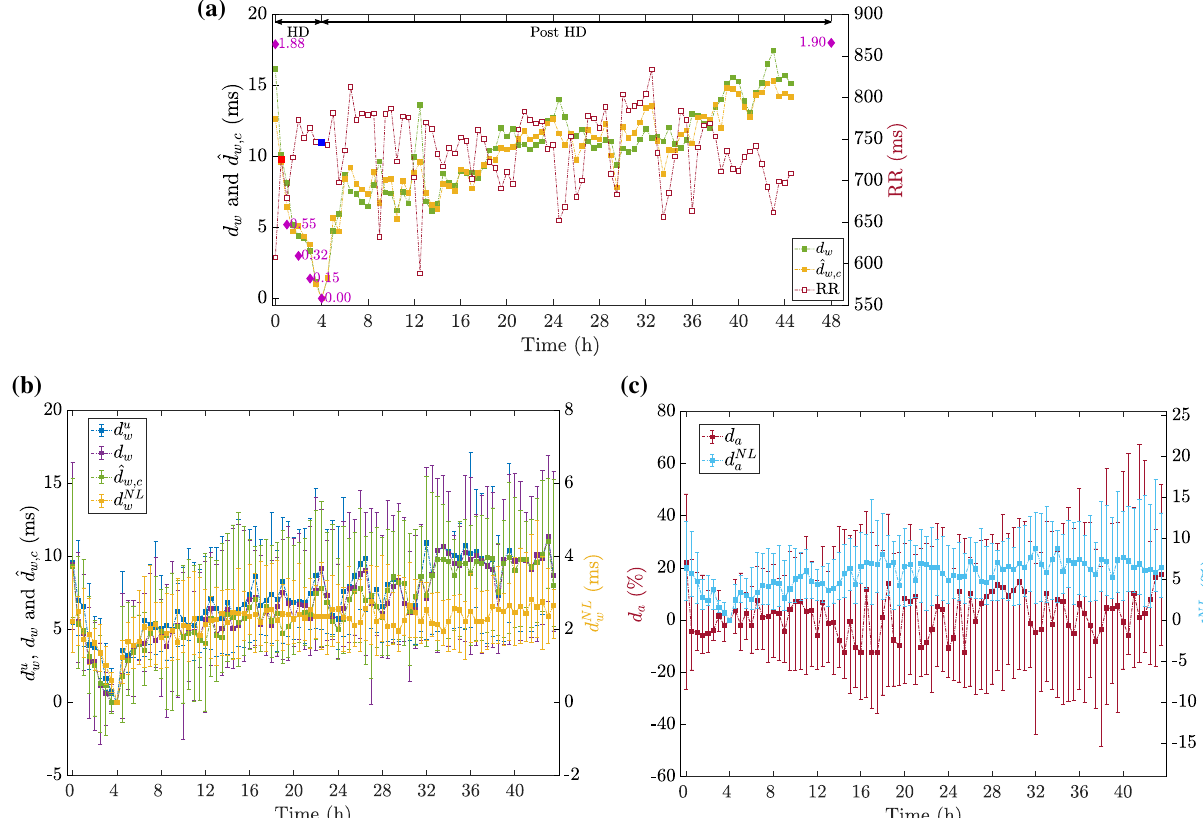
Figure 5. PCA-based time-warping markers and RR interval time trends. An example for a given patient undergoing 4h-long HD therapy, is depicted in panel ( a ) with the evolution of d w (filled green squares), (filled orange squares), both referring to the left vertical scale, and the average RR intervals (unfilled dark red squares, referring to the right vertical scale). (cid:31) [ K + ] relative variations with respect to the concentration at HD end (purple diamonds) are expressed in mmol/L. Time is expressed in hours from the beginning of the treatment onward. Each square denotes the mean RR interval in a 2-min wide segment used to compute the warping parameters, while the highlighted blue square corresponds to the reference segment at the end of HD. The filled red square denotes the time-point from which the studied MWTW in Fig. 2b was selected. Note that for this patient, the Holter recording did not reach the planned 48h. Panel ( b ) shows the median and IQR for each observing i -th segment, computed by using the values from all the available patients for d u w , d w and and d NL w (this latter refers to the right axis, while the others to the left). Time trends (expressed as median and IQR) for d a and d NL a , referring to the left and right axes respectively are in panel ( c ). Panels ( b ) and ( c ) give an overview of the time evolution for these biomarkers along the ECG acquisition from the HD beginning onward. Only the first 44 h were depicted being that the average ECG duration in our